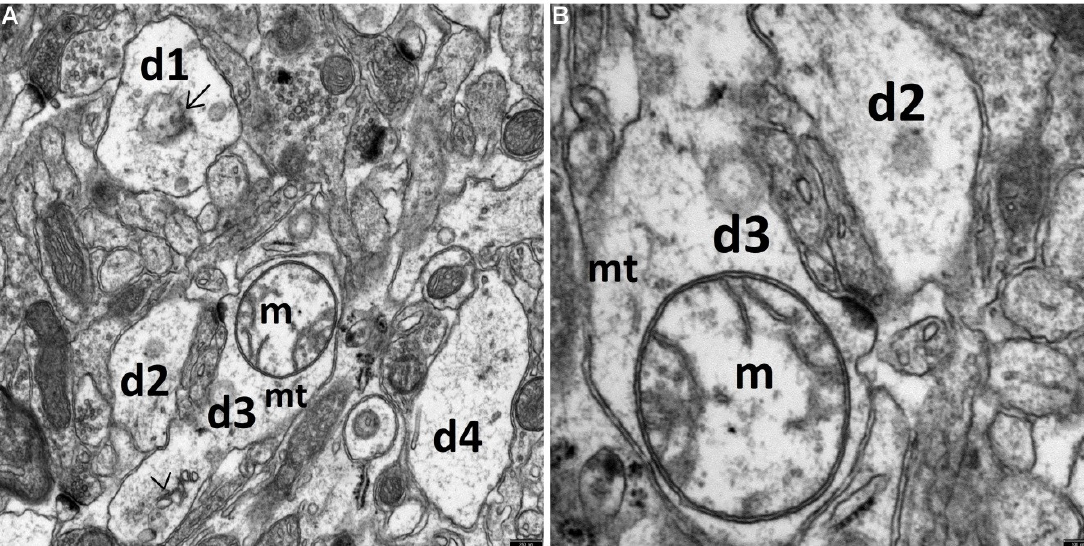
Figure 3. The cytoplasm of numerous synaptic endings of the temporal lobe neocortex is markedly swollen, without distinct features of the protective effect of the drug on the ultrastructure of these endings in the HS + TPM group. ( A ) The picture of degenerated, markedly enlarged synaptic endings, mainly dendritic ones (d1, d2, d3, and d4), containing the microfilament elements of the cytoskeleton. The cytoplasm of the centrally located dendritic ending (d3) contains markedly swollen mitochondrion (m) with peripherally arranged fragments of cristae within the mitochondrial matrix; transverse sections through dilated channels of the granular endoplasmic reticulum (>); and single residual microtubules (mt). The cytoplasm of the dilated postsynaptic part of the synapse (d1) located in the upper part of the figure contains a disintegrating structure, presumably a mitochondrion ( → ). The synaptic active zones are substantially shortened. A greater magnification ( B ) well demonstrates morphological details visible within the dendroplasm of the centrally located synaptic ending (d3). Scale bar: 250 nm ( A ) and 100 nm ( B ).